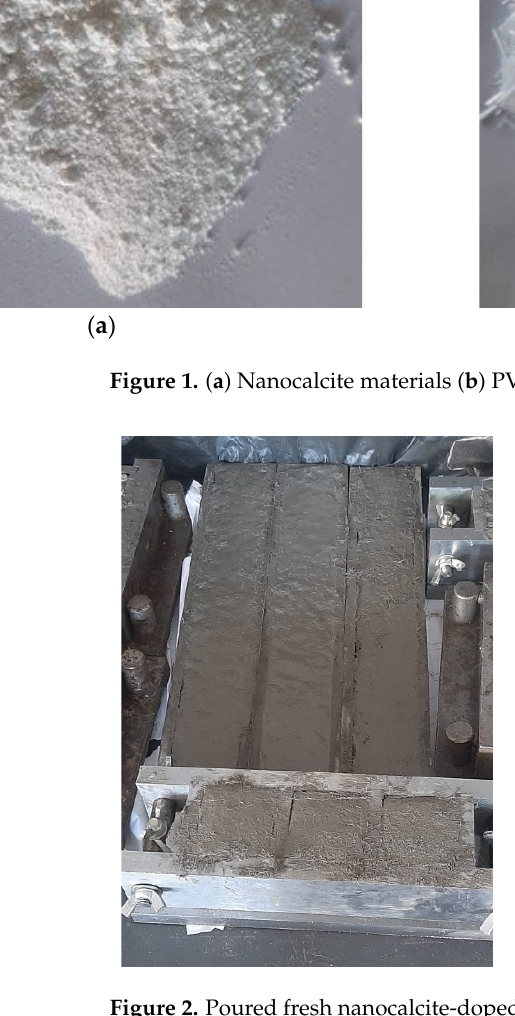
Table 3. Mixture ratios of nanocalcite-doped ECC series.